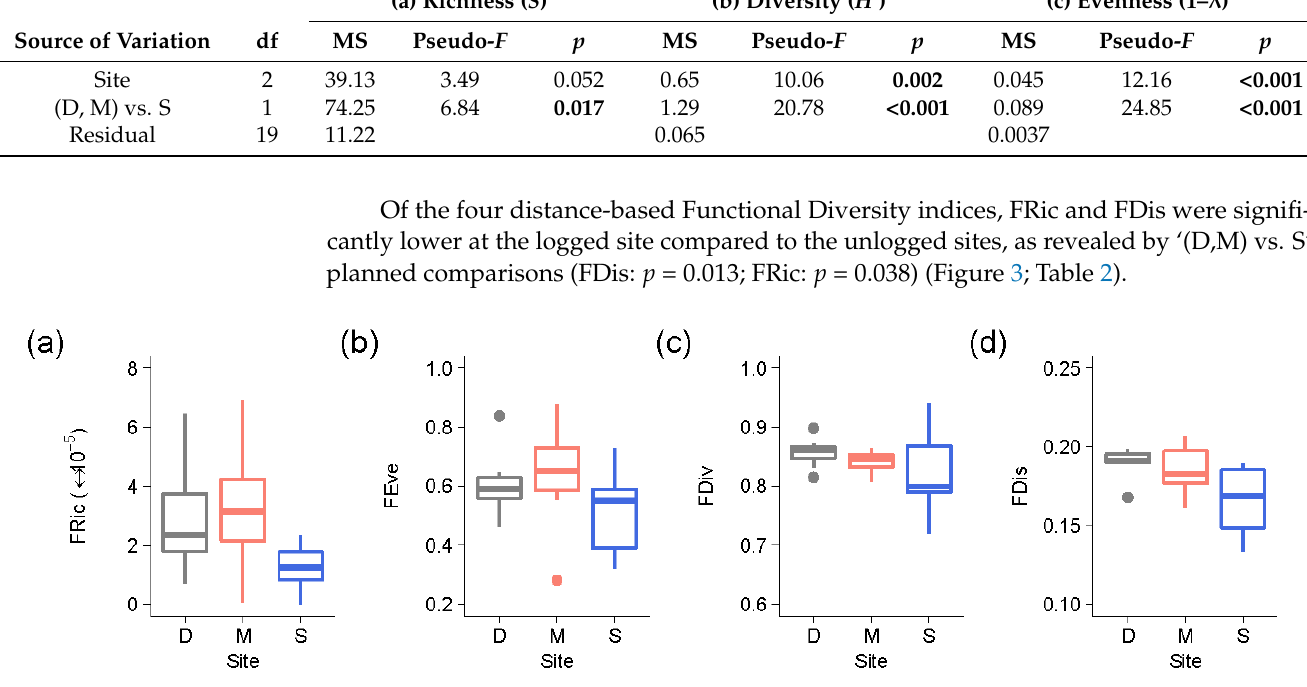
Figure 3. Boxplots of ( a ) functional richness (FRic), ( b ) functional evenness (FEve), ( c ) functional divergence (FDiv) and ( d ) functional dispersion (FDis) calculated for lichen functional groups versus site (D = Danum, M = Maliau [old growth sites]; S = SAFE [logged site]). Colour codes are grey for Danum, red for Maliau and blue for SAFE. Table 2. PERANOVAs testing the effects of site (D = Danum, M = Maliau, S = SAFE) on (a) functional richness (FRic), (b) functional evenness (FEve), (c) functional divergence (FDiv) and (d) functional dispersion (FDis) calculated for lichen functional groups, including planned comparisons between old growth (D, M) and logged (S) sites. Significant Monte Carlo p values are highlighted in